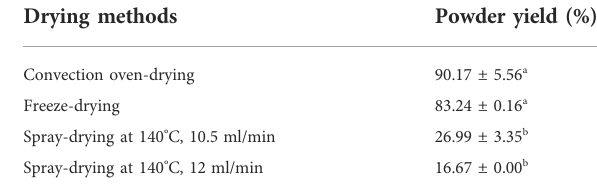
TABLE 1 Powder yield of convection oven-drying, freeze-drying and